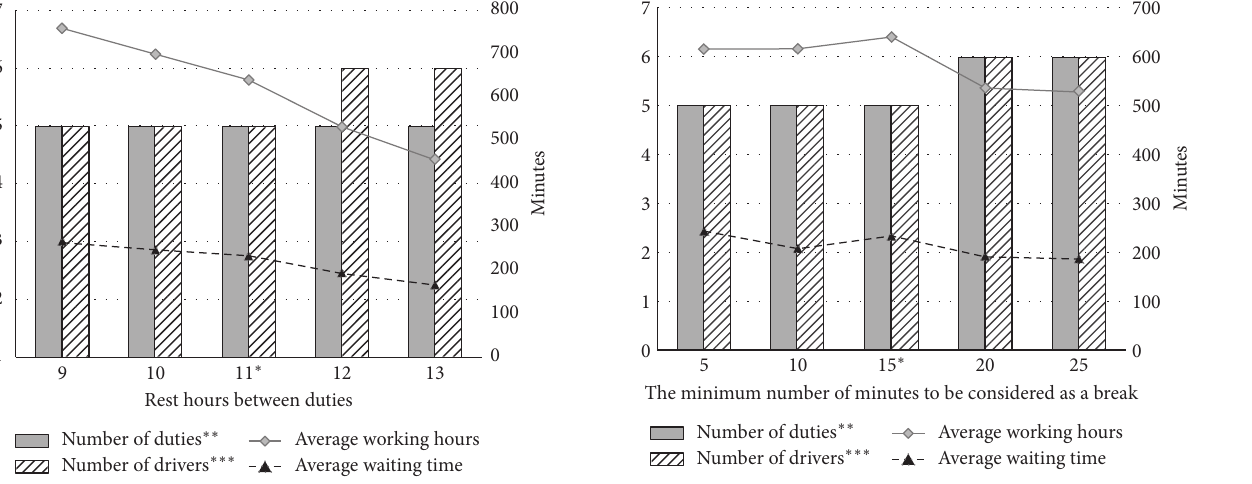
Figure 12: Sensitivity analysis of the rest hours between duties. Note . ∗ Current value and comparison basis. ∗∗ The number of duties required to cover the timetable. ∗∗∗ The number of drivers required for the roster.